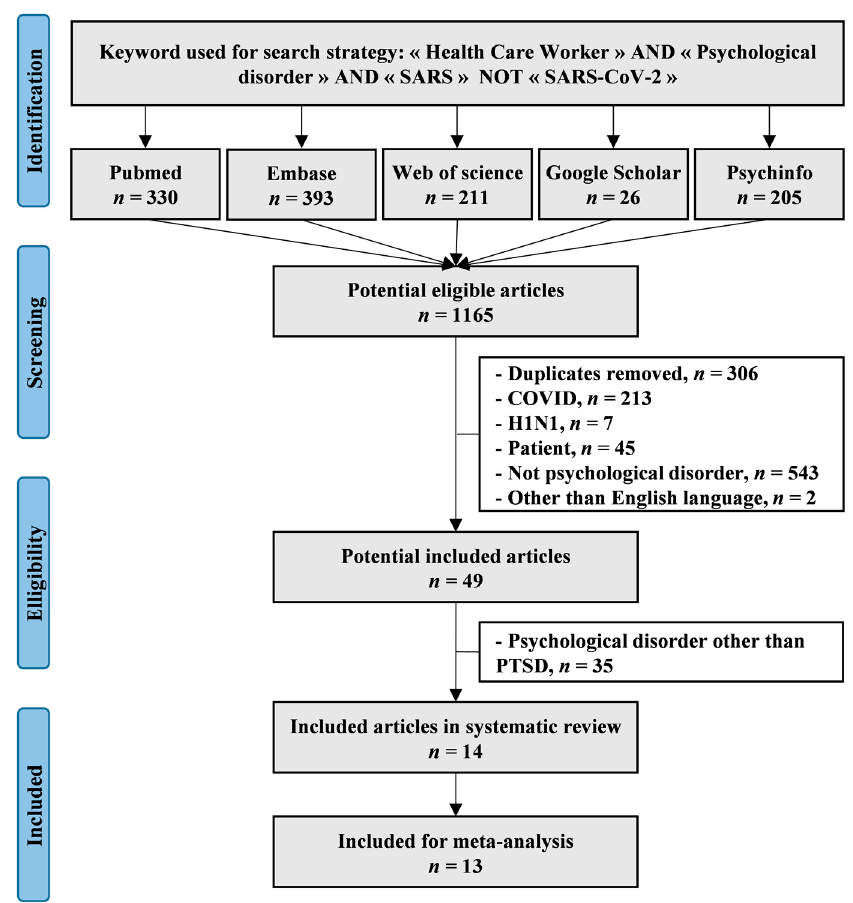
Figure 1. Flow chart, i.e., flow diagram of study selection following the Preferred Reporting Items for Systematic Reviews and Meta-Analyses (PRISMA).